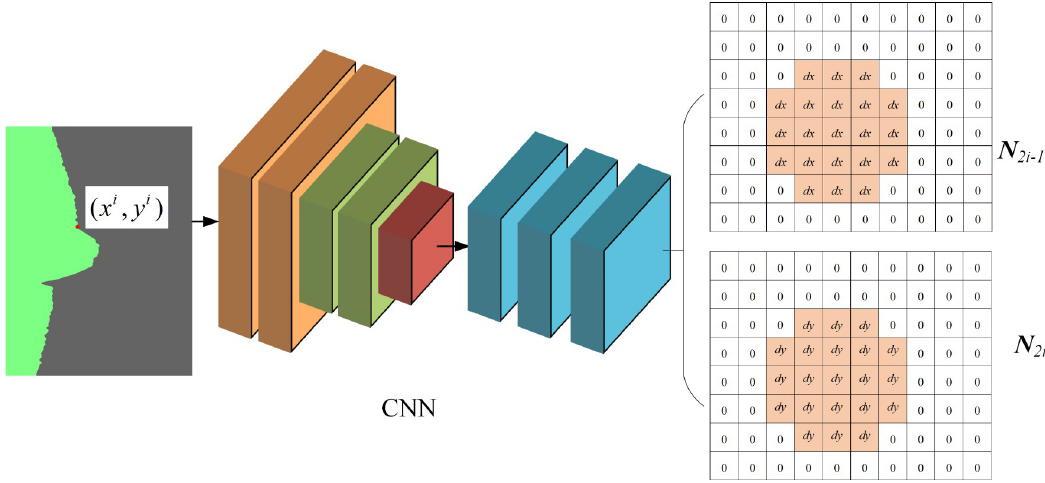
Fig 8. Theoretical output results of EDE-net branch